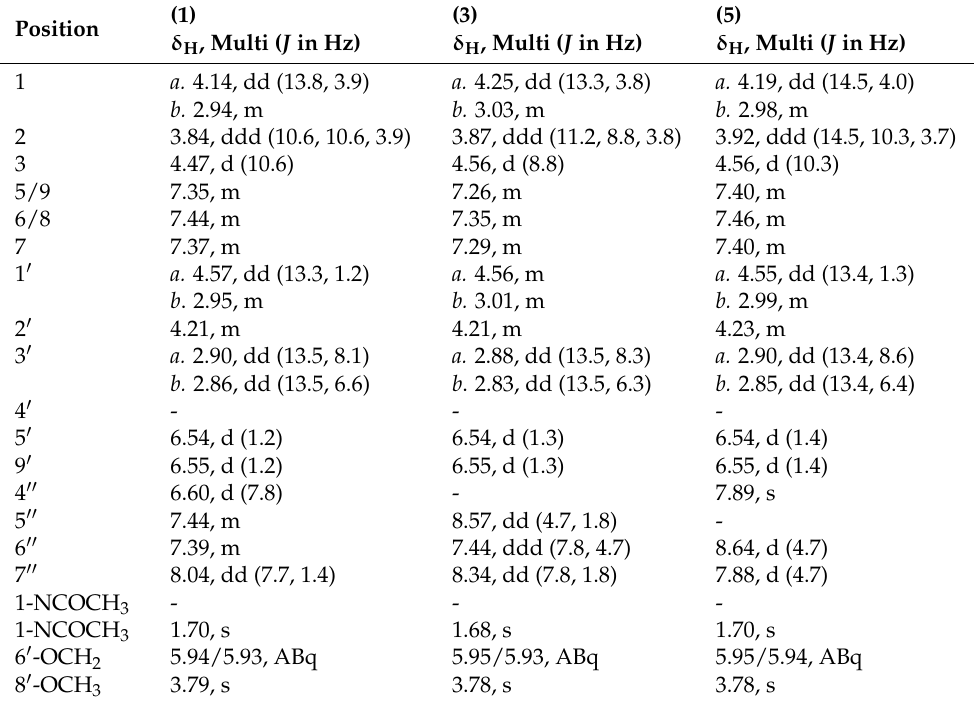
Figure 6. Known chrysosporazine C ( 9 ), azachrysosporazine C1 ( 11 ) and neochrysosporazine I ( 13 ), and seco analogues, chrysosporazine D ( 7 ), azachrysosporazine D1 ( 12 ) and neochrysosporazine J ( 14 ). Table 1. 1 H NMR (DMSO- d 6 ) data for 1 , 3 and 5 .